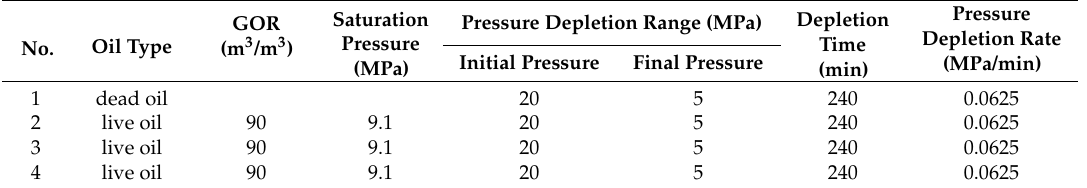
Table 6. The experimental parameters with dissolved